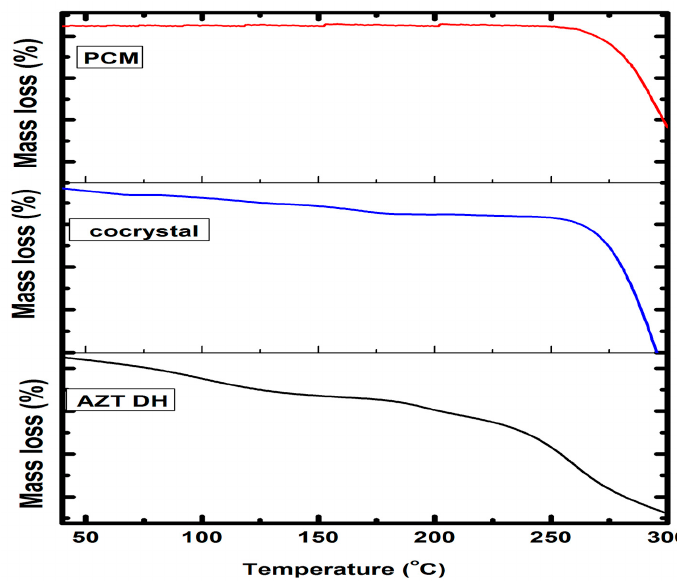
Figure 7. TGA thermograms of AZT DH, PCM and